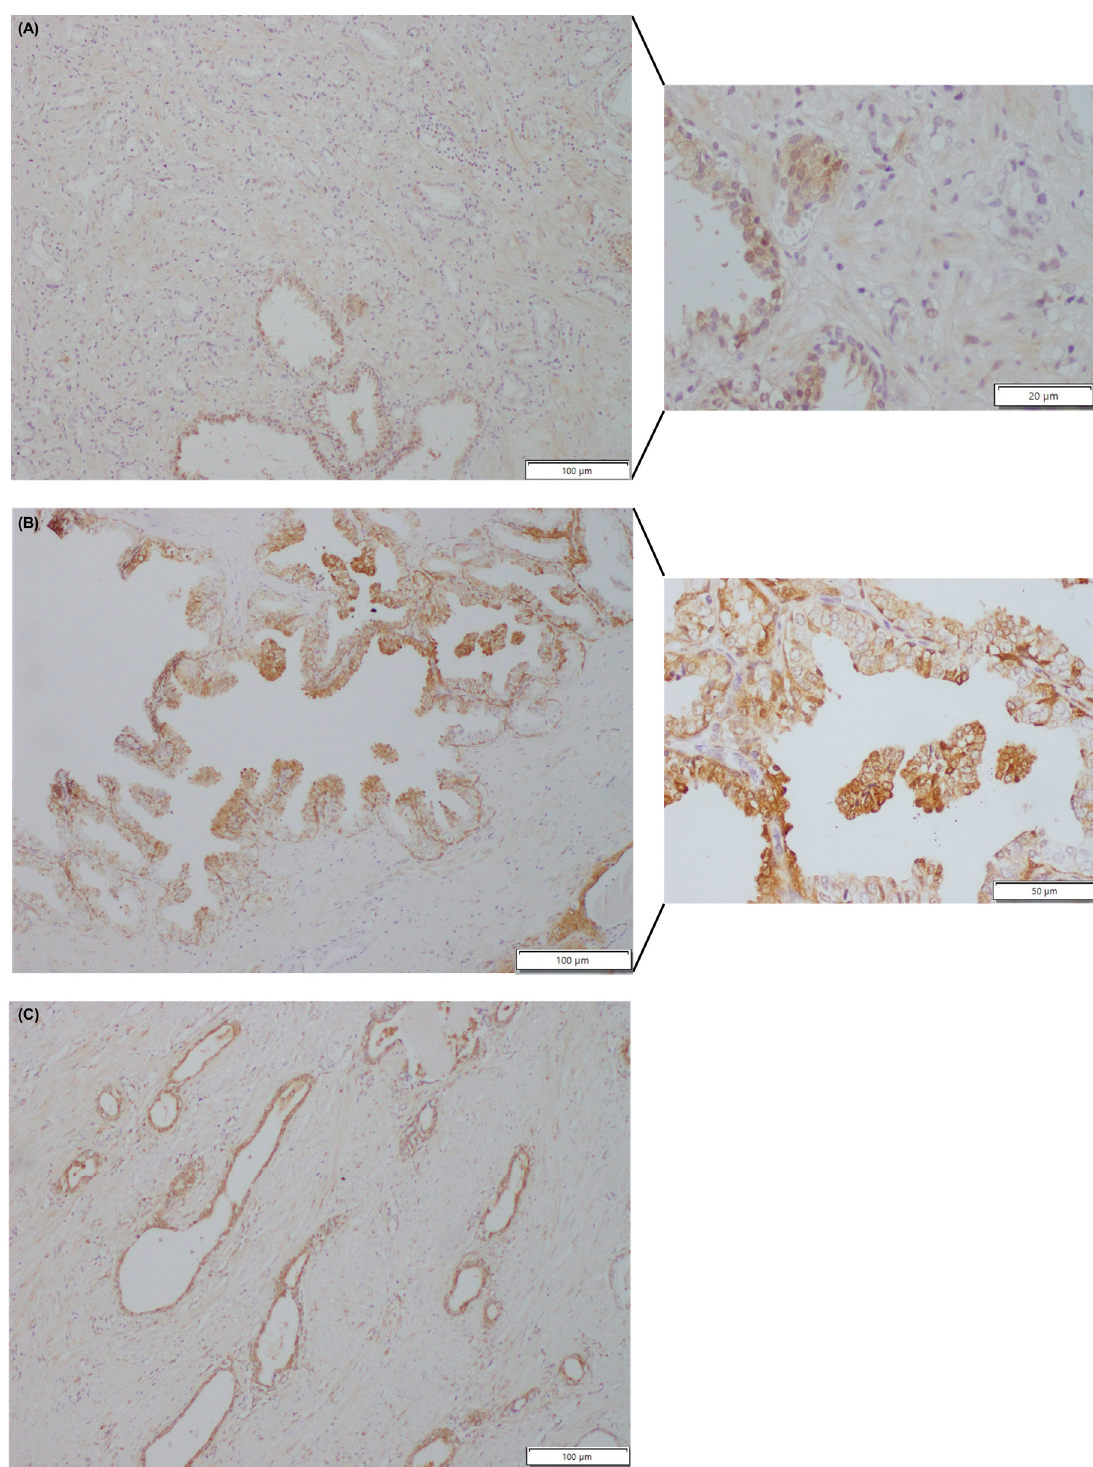
Figure 1. Gal-3 expression in prostate slides. ( A ) Tumour prostate tissue. Note: adenocarcinoma showing negative staining and non-neoplastic glands with moderate cytoplasmic and nuclear staining. ( B ) Adjacent-normal prostate tissue. Note: detail of non-neoplastic glands with nuclear membrane staining. ( C ) Non-neoplastic prostate. Atrophic glands showing moderate staining. Magnification factors of images A, B, C: ×10 and 40×; ×10 and 40×; 10×, respectively).